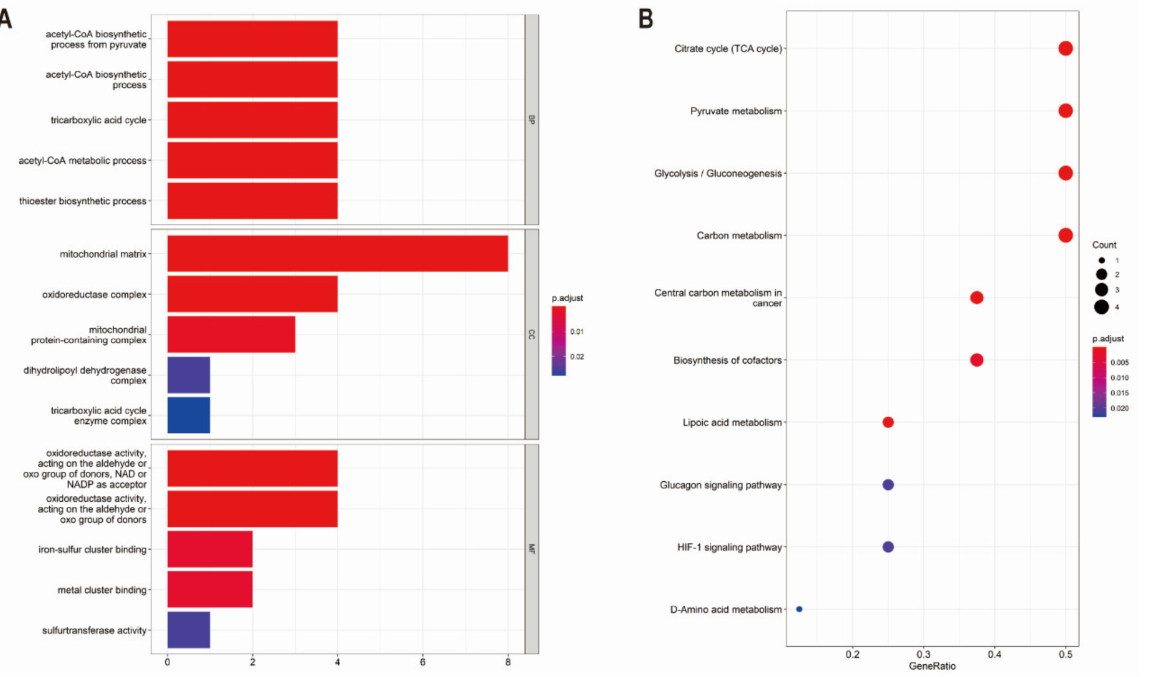
Figure 2. Pathway enrichment analysis of CRGs in ccRCC patients of TCGA: ( A ) the enriched item in the gene ontology analysis; ( B ) the enriched item in the Kyoto Encyclopedia of Genes and Genomes analysis. The size of circles represents the number of enriched genes. BP: biological process, CC: cellular component, MF: molecular function and CRG: cuproptosis-related